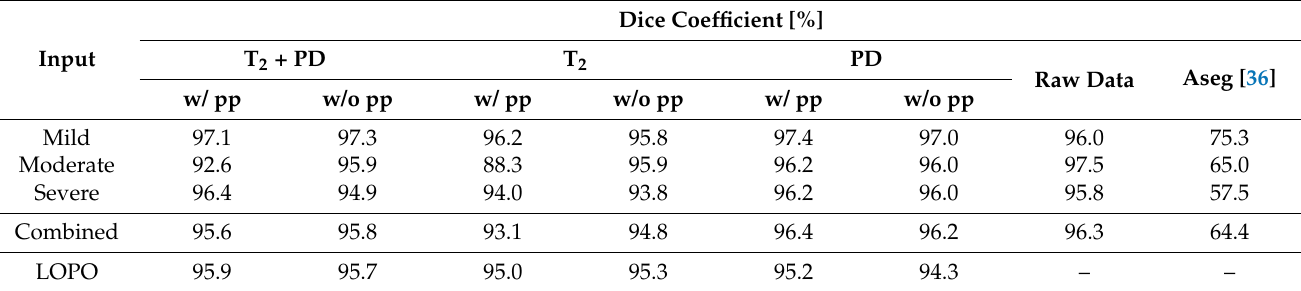
Table 1. Evaluation of the FCN muscle segmentation dice metric across different types of input data for three disease severity levels: mild, moderate, and severe. An overall Dice score was also calculated by combining all severity levels (combined) and by using a leave-one-patient-out (LOPO) procedure (pp: preprocessing; w/: with; w/o: without).